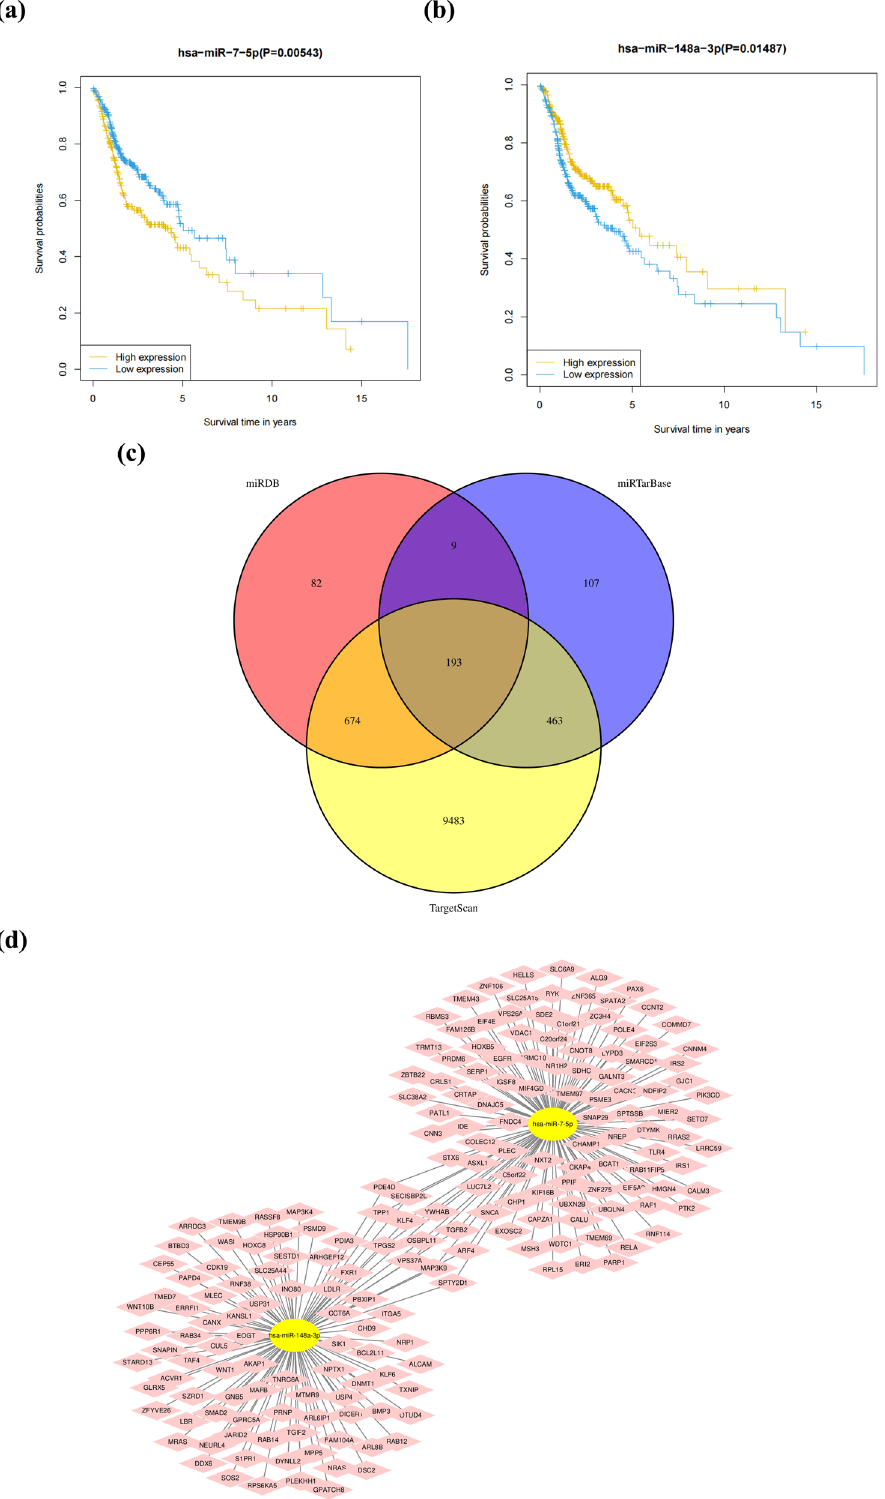
Figure 5: Survival analysis and the target genes prediction of the key prognostic miRNAs. ( a ) Kaplan – Meier curves for the OS of patients in the high and low expression groups of miR - 7 - 5p. ( b ) Kaplan – Meier curves for the OS of patients in the high and low expression groups of miR - 148a - 3p. ( c ) The Venn fi gure shows the number of consensus genes based on online databases TargetScan, miRDB, and miRTarBase. ( d ) The miRNA - gene pathway and annotation networks represent the relationships among miRNAs and consensus